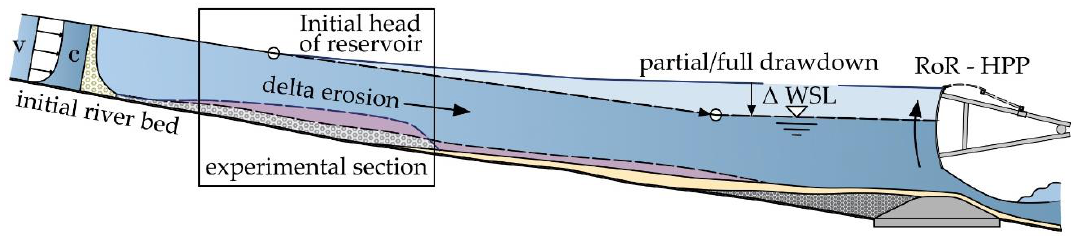
Figure 2. Section of a run-of-river hydropower plant (RoR-HPP) reservoir during a flood event and a partial drawdown, leading to free-flowing conditions in the experimental section.